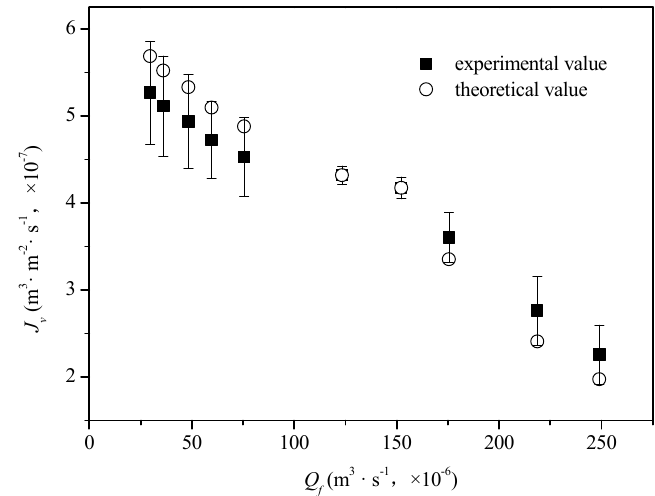
Figure 6. Comparison of the experimental and theoretical solvent flux values.